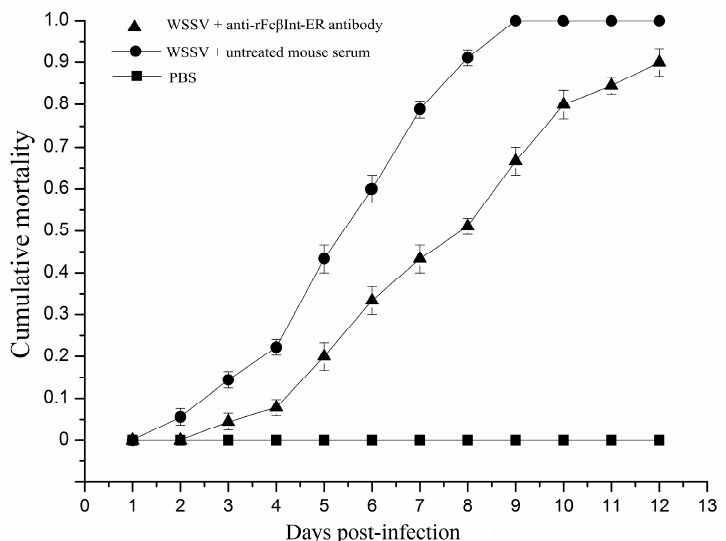
Figure 3. In vivo WSSV infection blocking assay with anti-rFc β Int-ER antibodies. Shrimp in all groups were challenged with WSSV, and the mortalities were recorded for 12 days. Shrimp injected with PBS were set as control. The bar represents the SD of the mean ( n = 3).